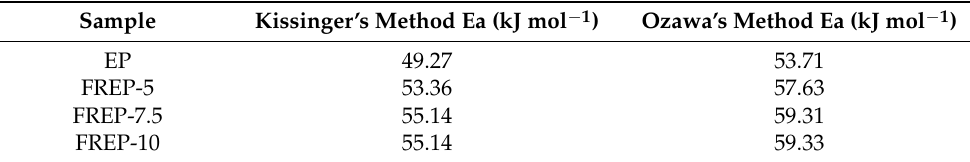
Table 2. Ea values calculated from non-isothermal DSC curves. Sample